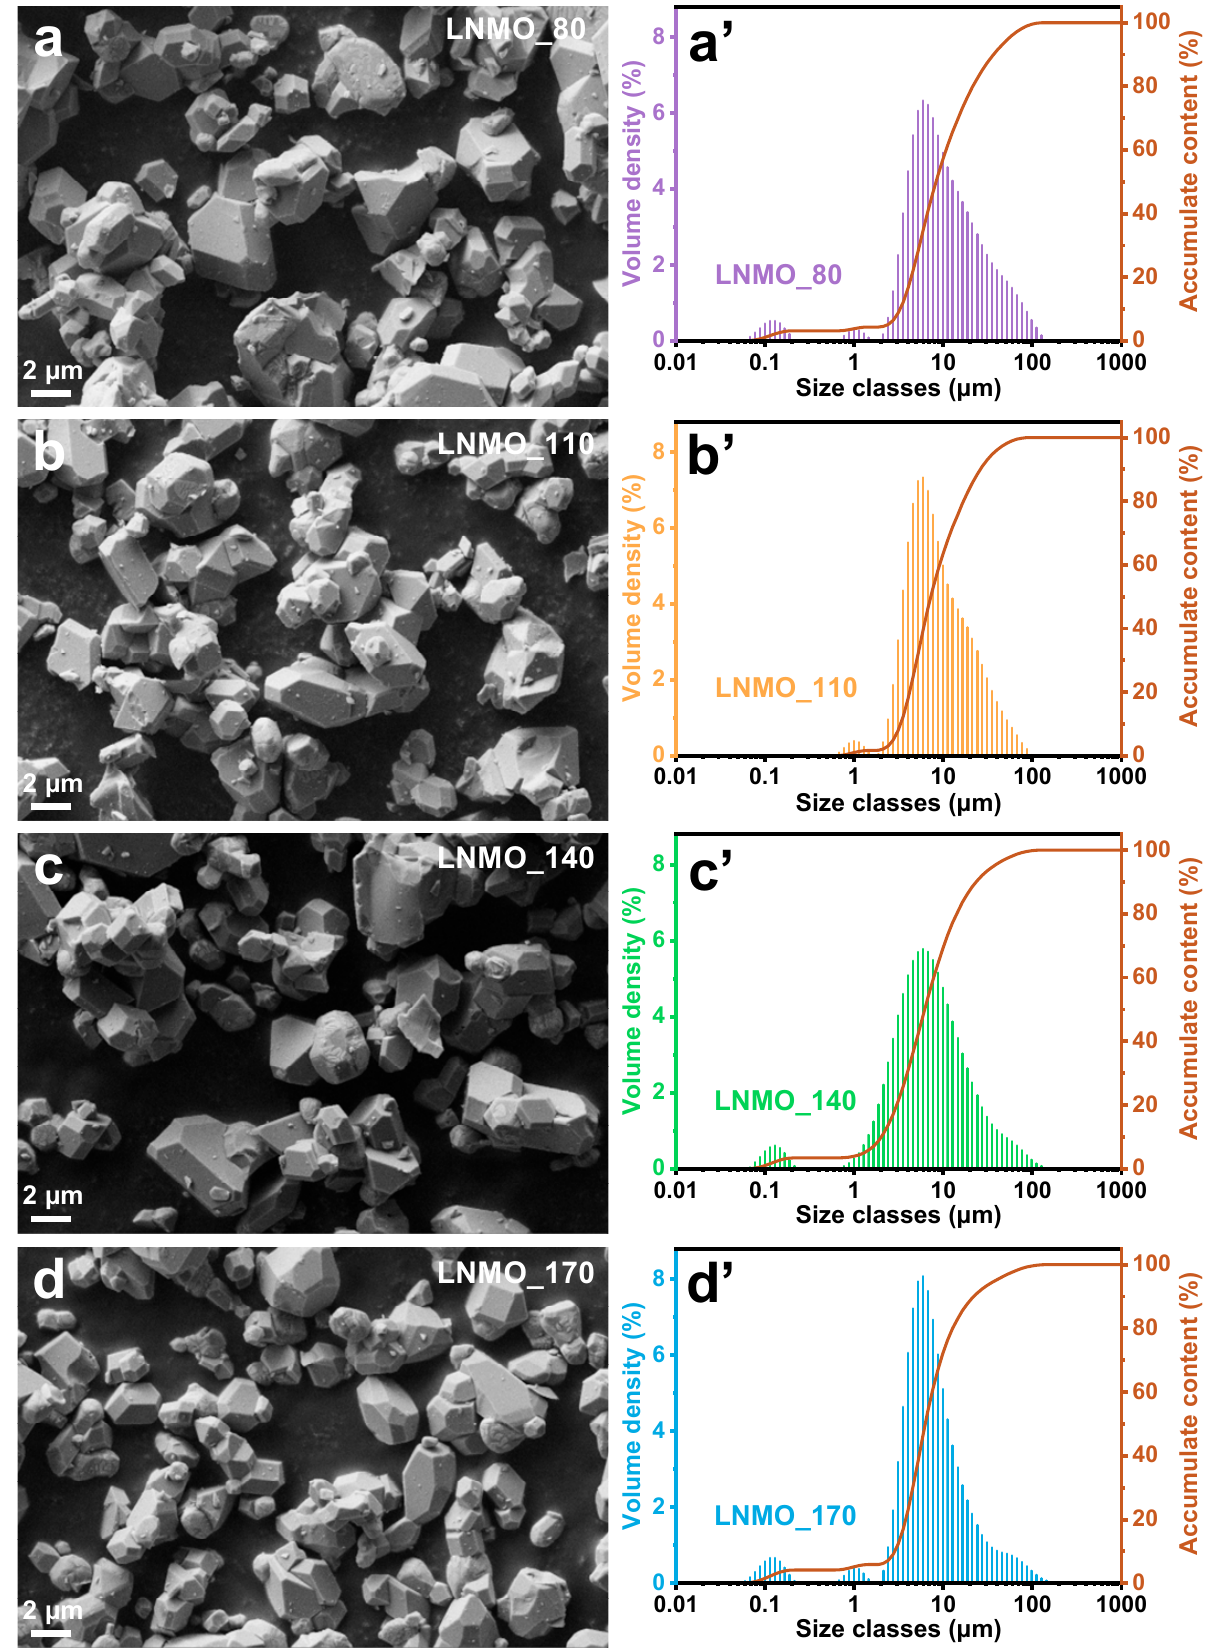
Figure 2. ( a – d ) SEM images and ( a’ – d’ ) PSD diagrams of LNMO_ x samples.